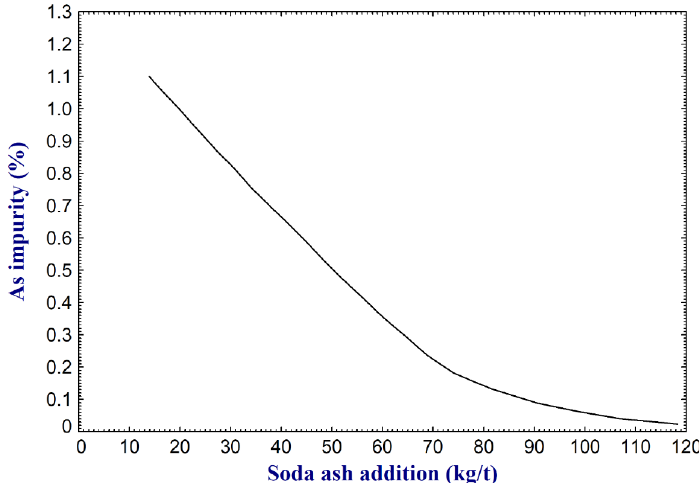
Figure 17. Arsenic content in antimony as a function of soda ash addition between 850 and 900 °C (adapted from [59]).